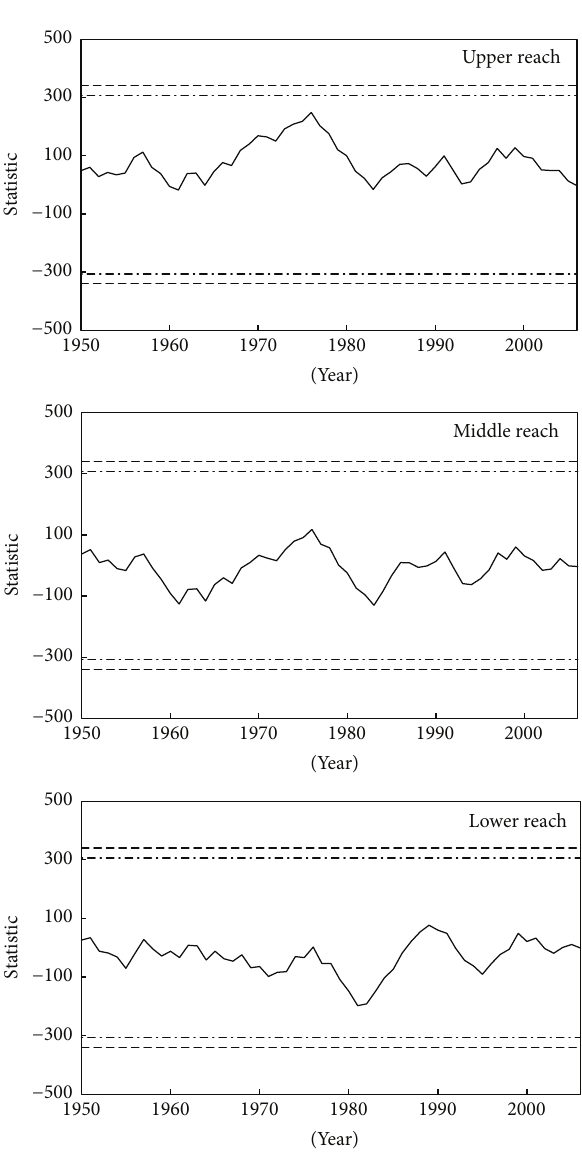
Figure 4: The results of change point analysis using Pettitt test.